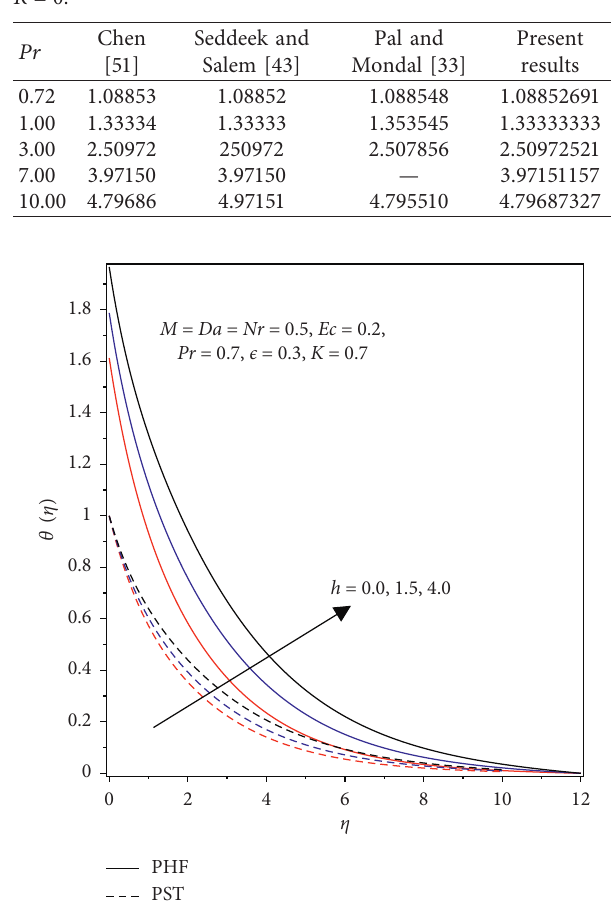
Figure 2: Impact of viscosity parameter h on the field of